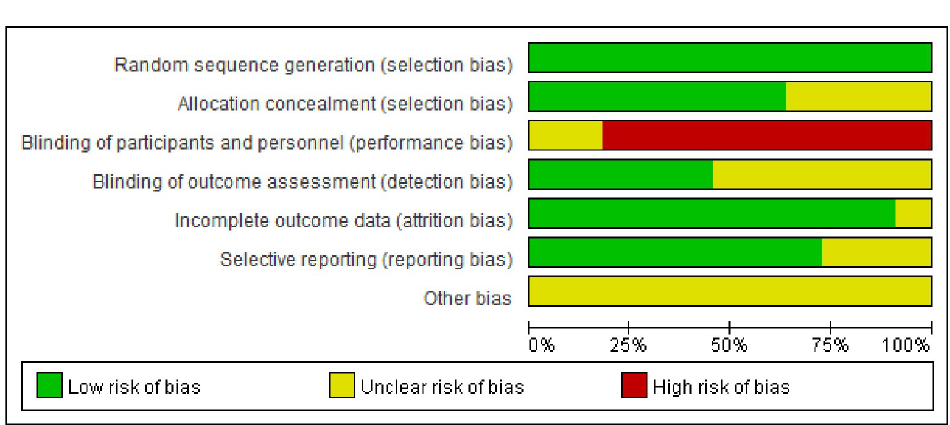
Fig 2. Risk of bias graph: Review authors’ judgements about each risk of bias item presented as percentages across all included studies.